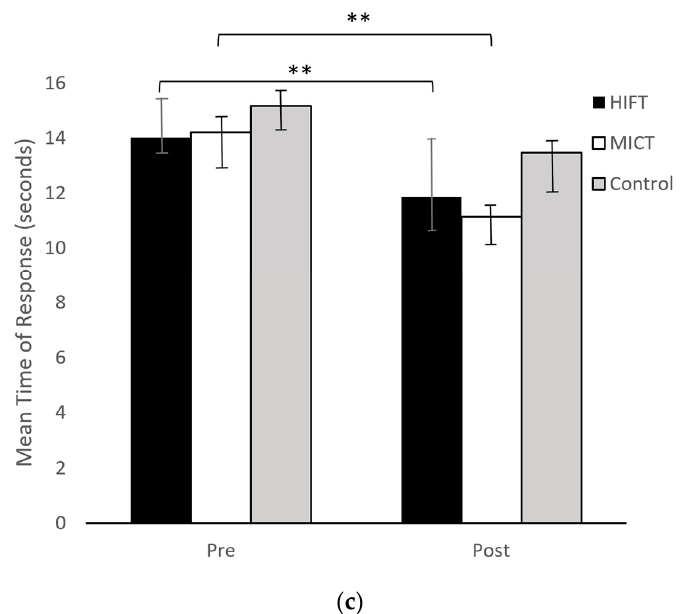
Figure 2. This figure shows the boxplot of the pre- and post-tests in the Stroop Test of each group in the three statistically significant variables. ( a ) Number of Correct Answers; ( b ) Fast Response Time; ( c ) Mean Response Time. * p < 0.05. ** p < 0.01